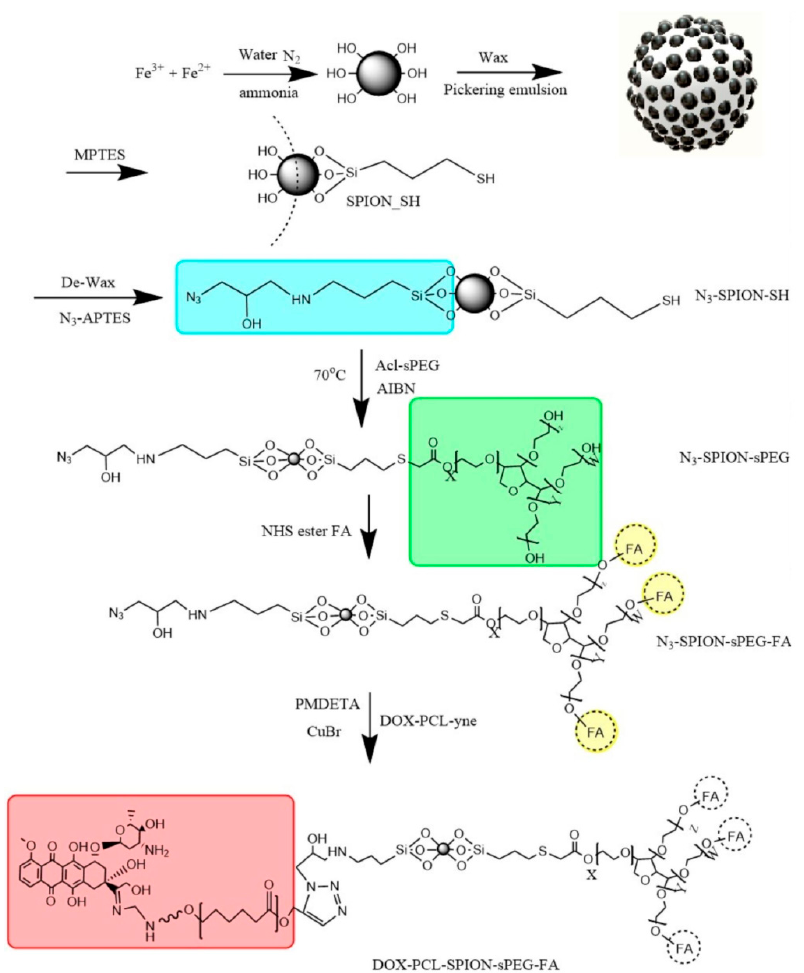
Figure 2. Scheme of the steps involved in the synthesis of drug-conjugated Janus nanoparticles (NPs). Reprinted from Reference [26] with permission.